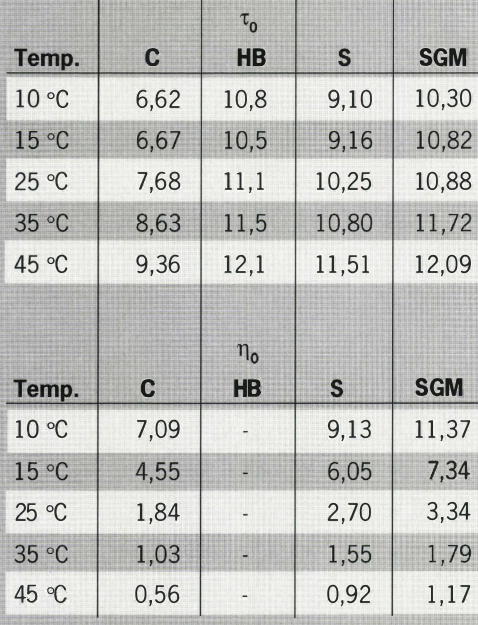
Table 3: Effect of temperature on the parameters of the correlation modela according to Casson (C}, Herschei-Bulkley